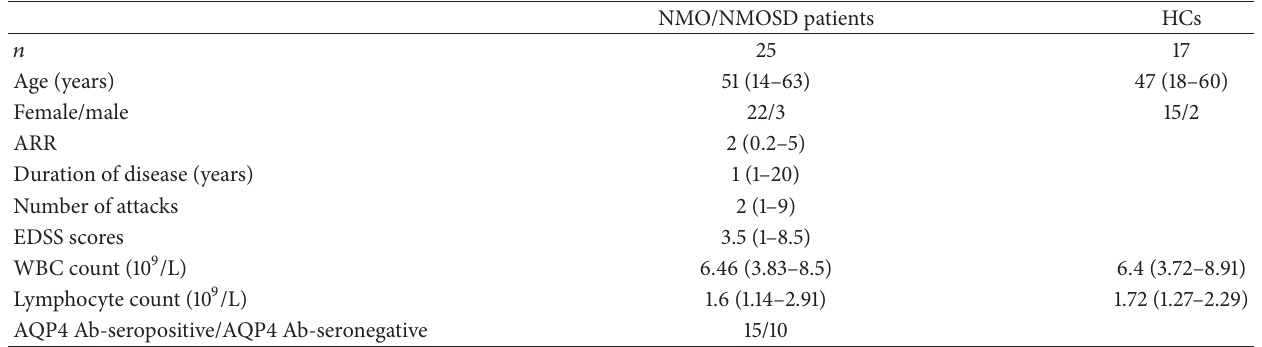
Table 1: The demographic and clinical features of NMO/NMOSD patients and HCs.